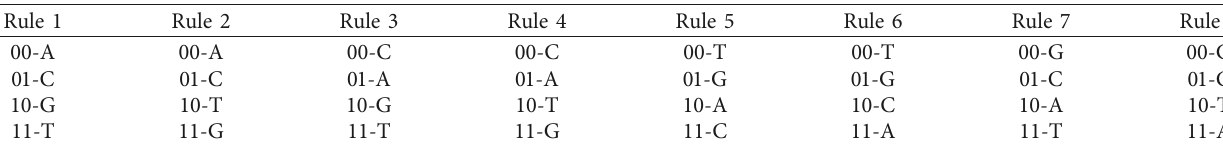
Figure 12: Debugging diagram of oscilloscope. Table 1: 8 kinds of schemes encoding rule of DNA